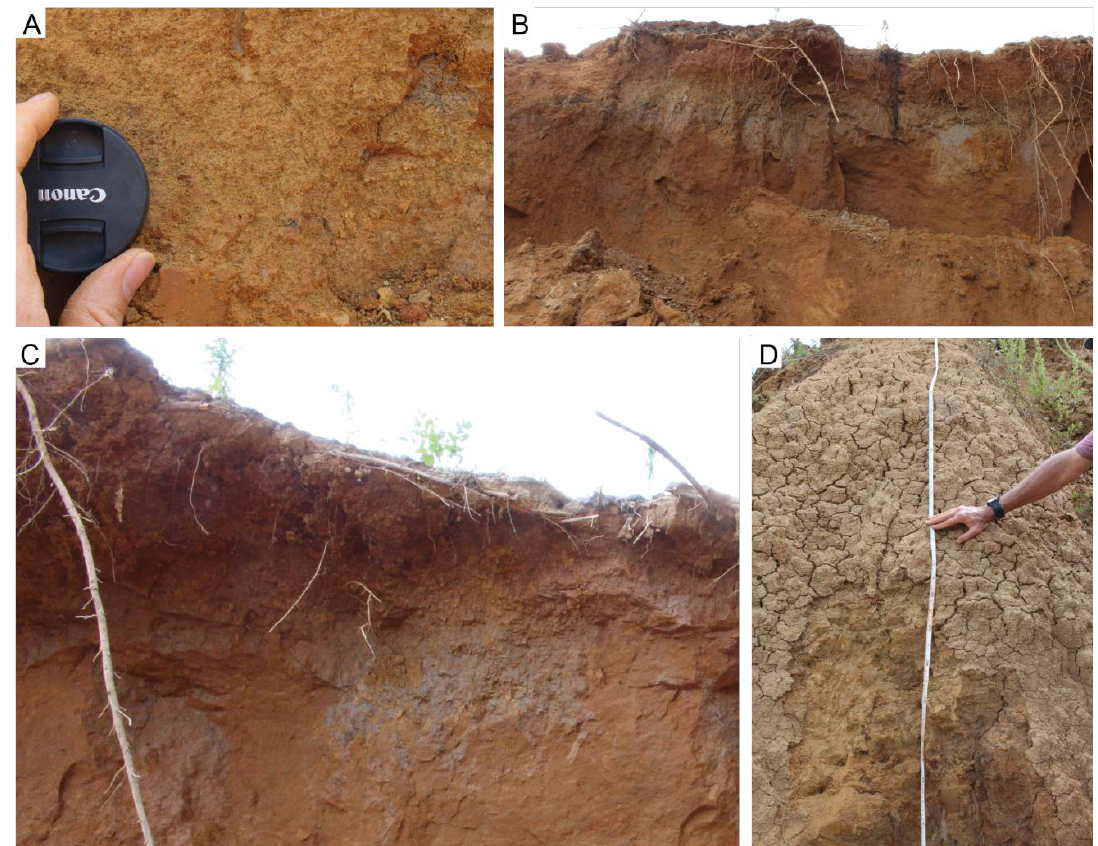
Figure 5. Sandy clay lithofacies. ( A ) Spherical clay aggregates in outcrop at the southern Pontotoc site. Lens cap is 5.5 cm in diameter. ( B ) Gray lens of sandy clay lithofacies exposed in high wall of quarry at southern site. Lens is ~0.5 m thick. ( C ) Portion of lens in B showing diffuse lower boundary possibly from bioturbation. ( D ) Cracked surface weathering pattern indicating the presence of expansive clays. Tape measure is marked in cm.